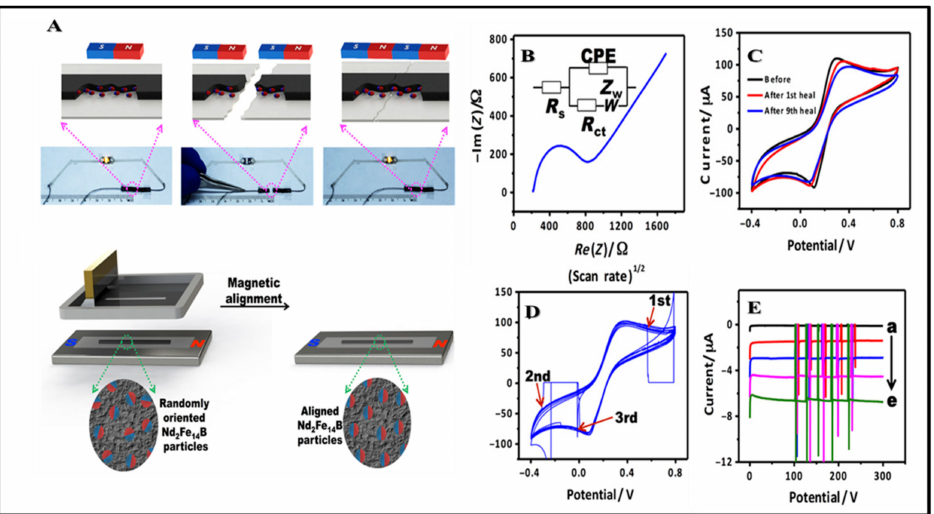
Figure 4. ( A ) Schematic diagram to illustrate the fabrication of self-healing principle and the manufacturing process; ( B ) Nyquist plot for self-healing printed electrodes; ( C ) cyclic